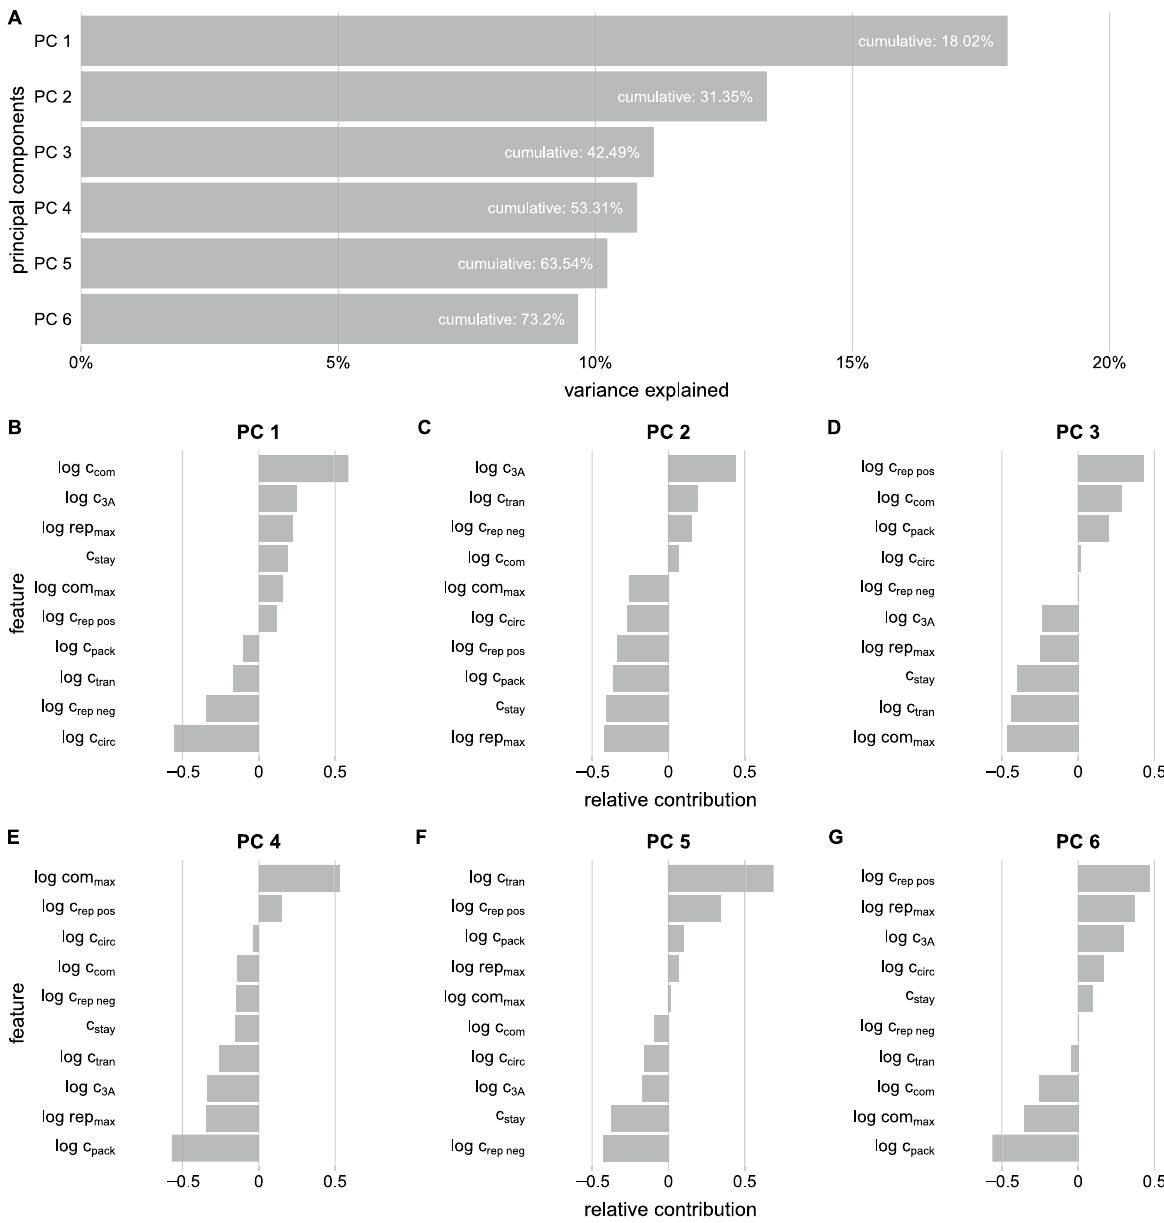
Figure 5. Principal component analysis of parameter distributions estimated from fitting our mechanistic model of PV infection to experimental data (Fig. 1C–F). ( A ) The amount of variance explained by the first 6 principal components. The white labeling provides the cumulative amount of variance explained by including all components up to and including the labeled one. ( B – G ) Relative contribution of features for each of the first six principal component